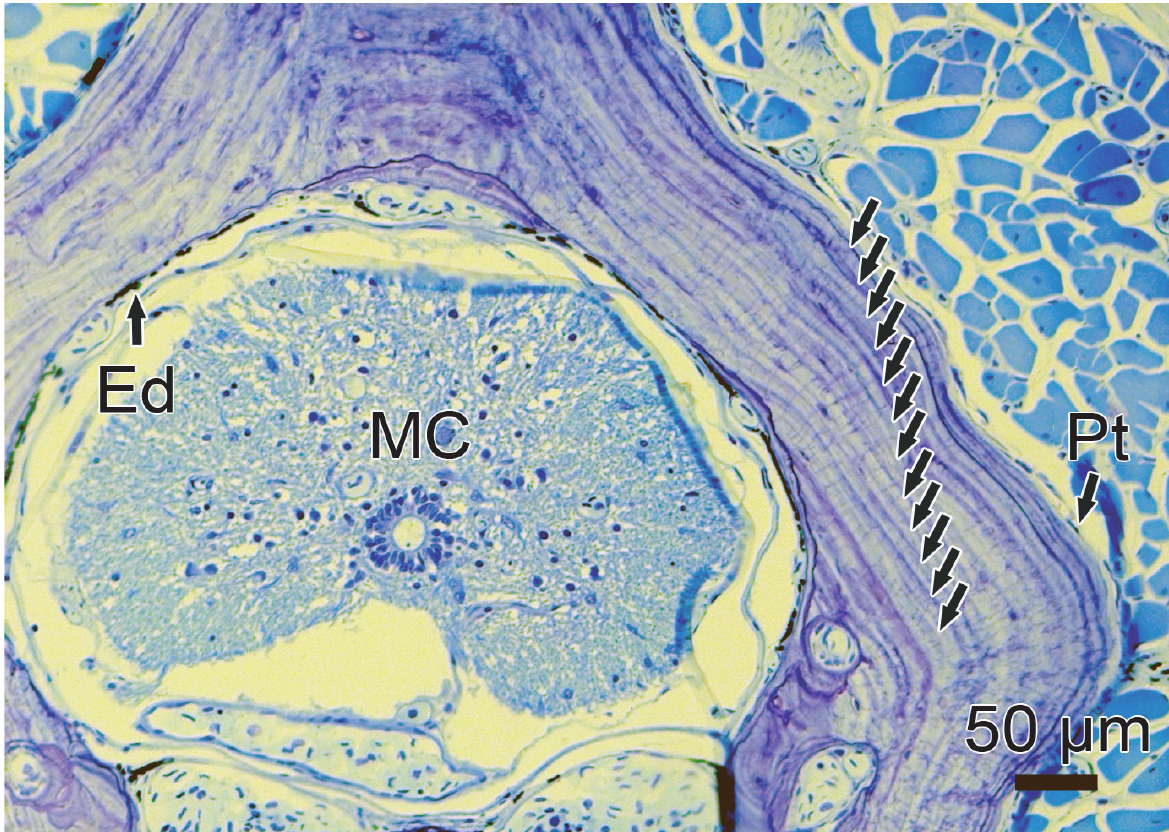
Figure 5. Transverse section of caudal vertebrae of a twelve-year (12) old Thamnodynastes strigatus . Arrow indicates individual growth layers. Ed: endosteum Pt: periosteum MC: spinal cord. Light microscopy of samples stained with toluidine